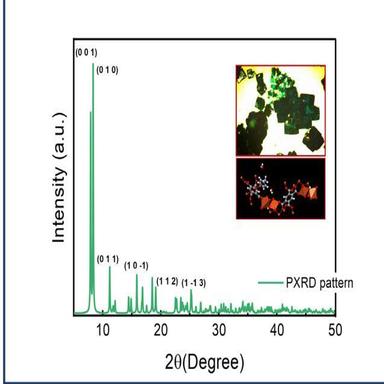
PXRD pattern of Cu-B-MI-MOF with optical microscopy image of Cu-B-MI-MOF in the inset.